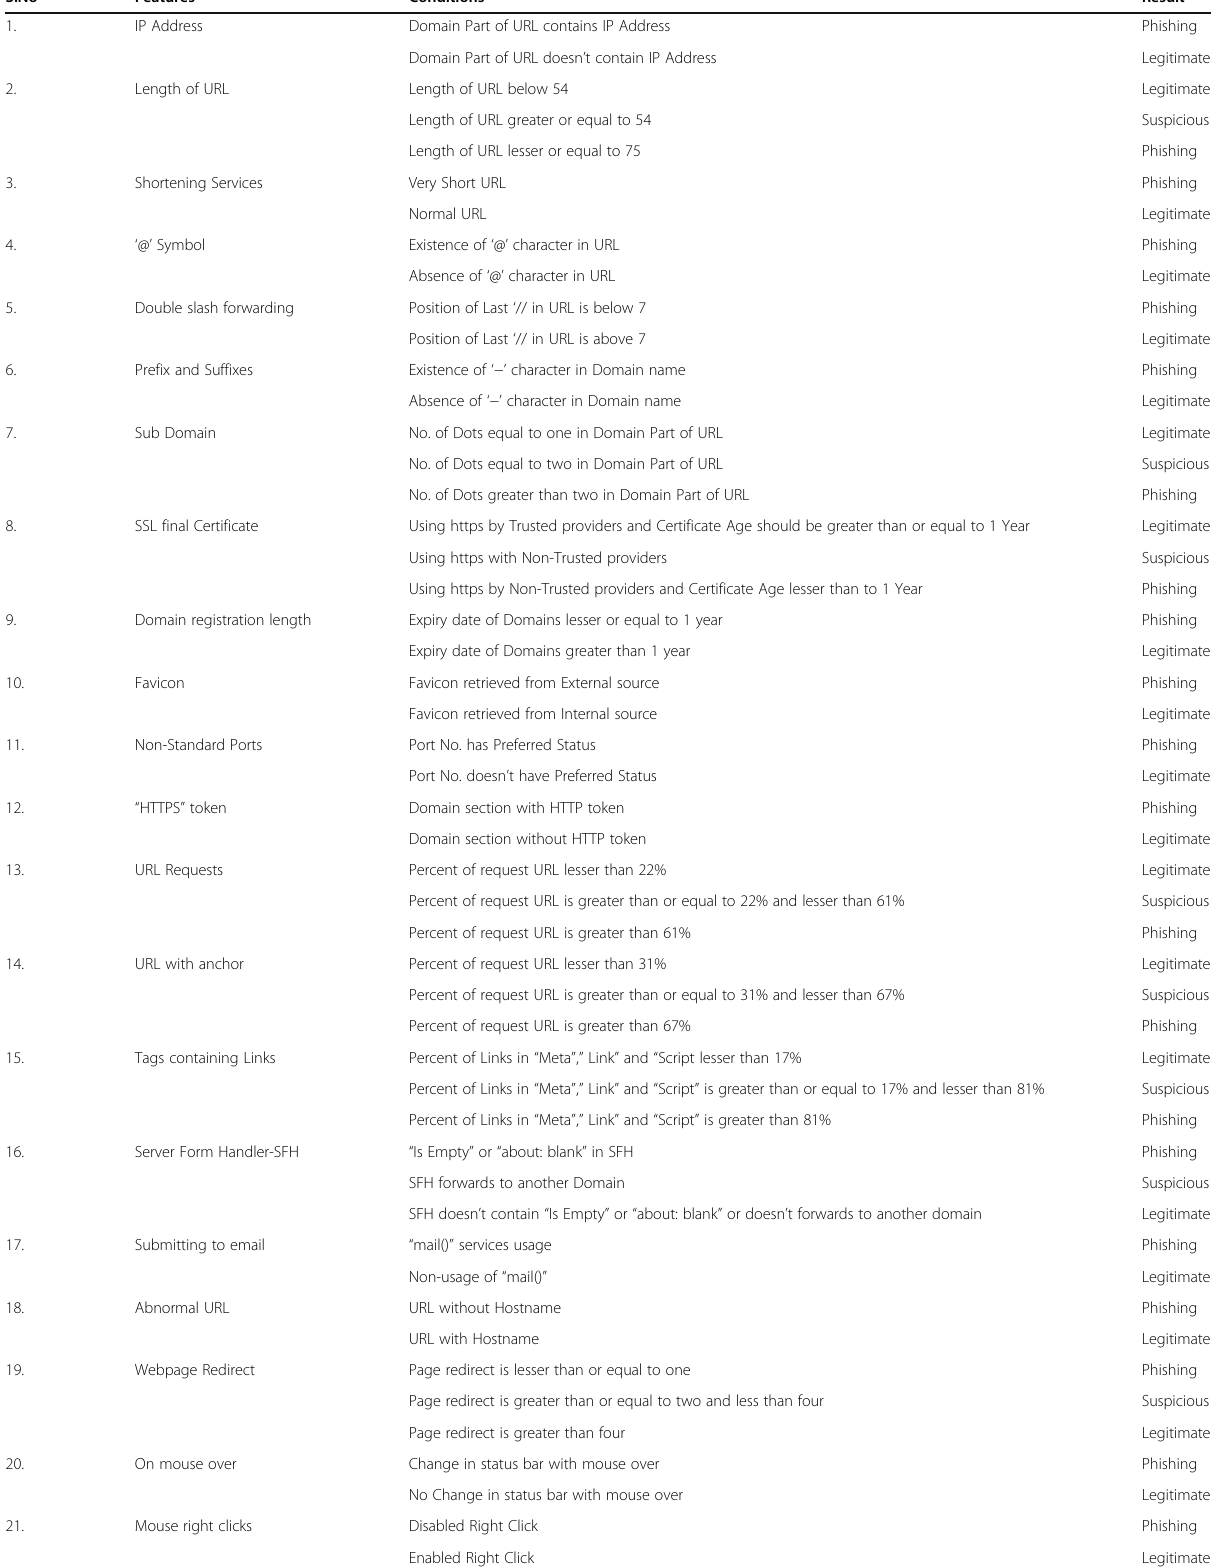
Table 2 A list of 30 distinct